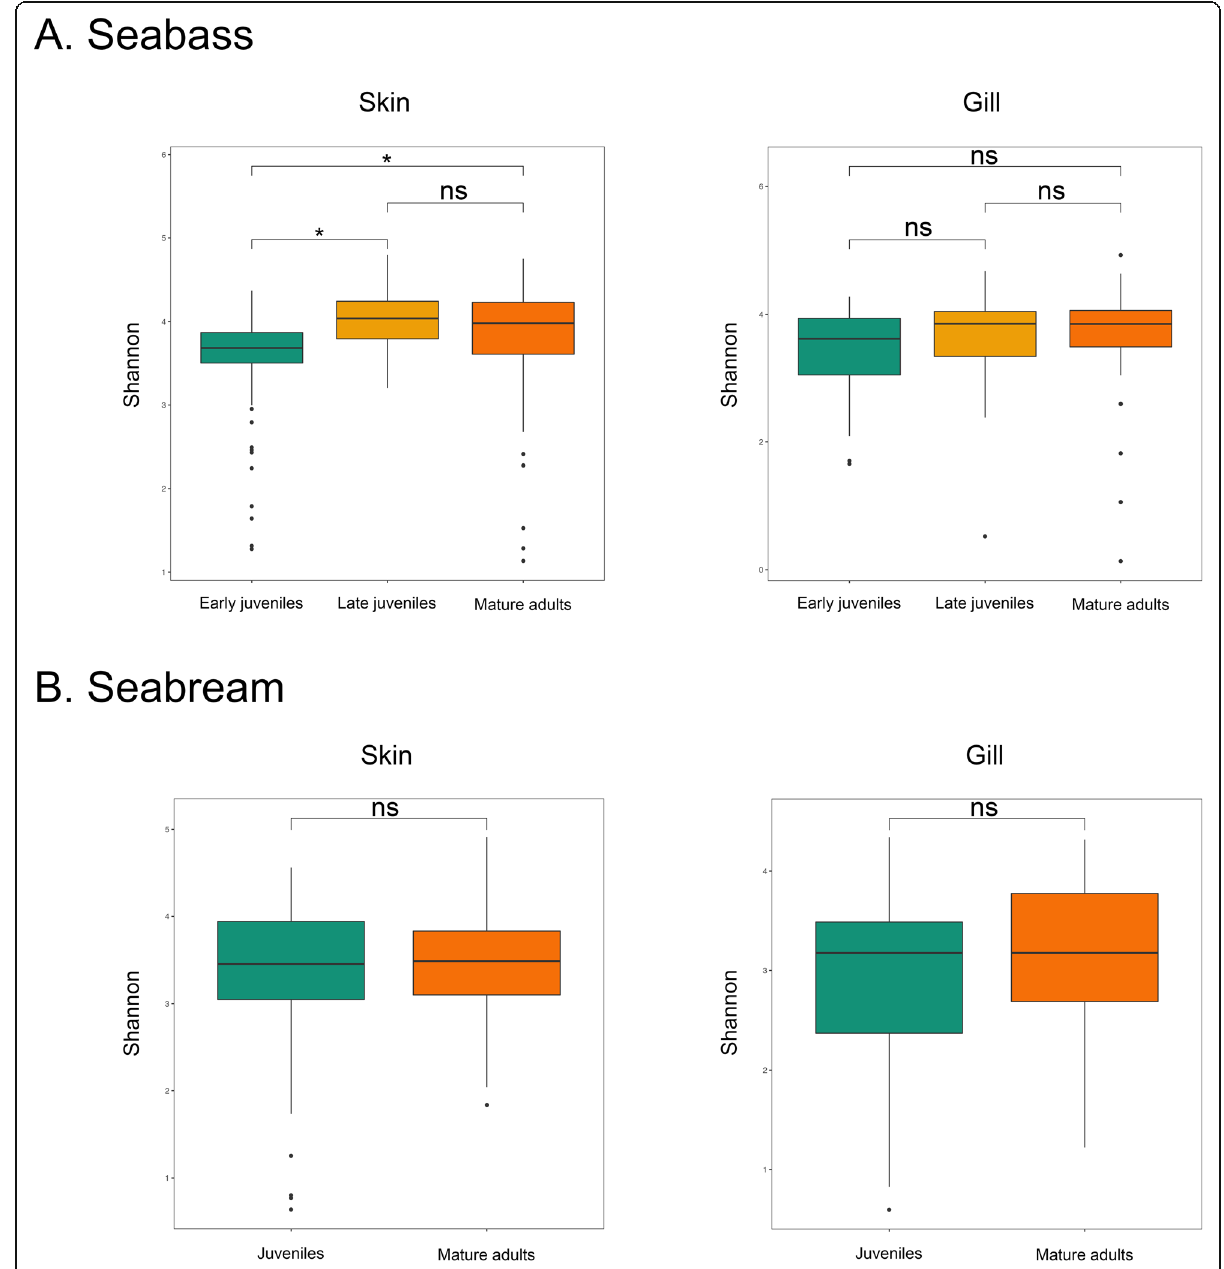
Fig. 1 Mean values and standard deviations of Shannon alpha-diversity estimates plotted for the early juveniles/juveniles (green), late juveniles (yellow) and mature adults (orange) of the seabass Dicentrarchus labrax ( a ) and the seabream Sparus aurata ( b ) ( n = 60 per species x age group x tissue). Pairwise comparisons of alpha-diversity were assessed using Linear Mixed Effect models with age groups as a fixed factor and sampling time as a random factor. Statistically significant differences are denoted with an asterisk and non statistically significant differences with “ ns